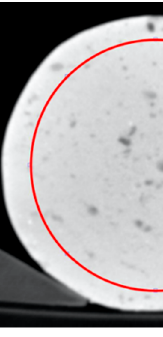
Figure 12. Image cutting.